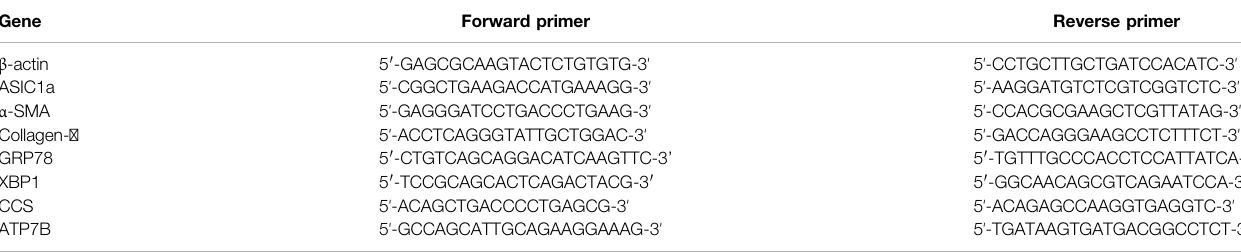
TABLE 1 | Primer sequences of several genes for real-time